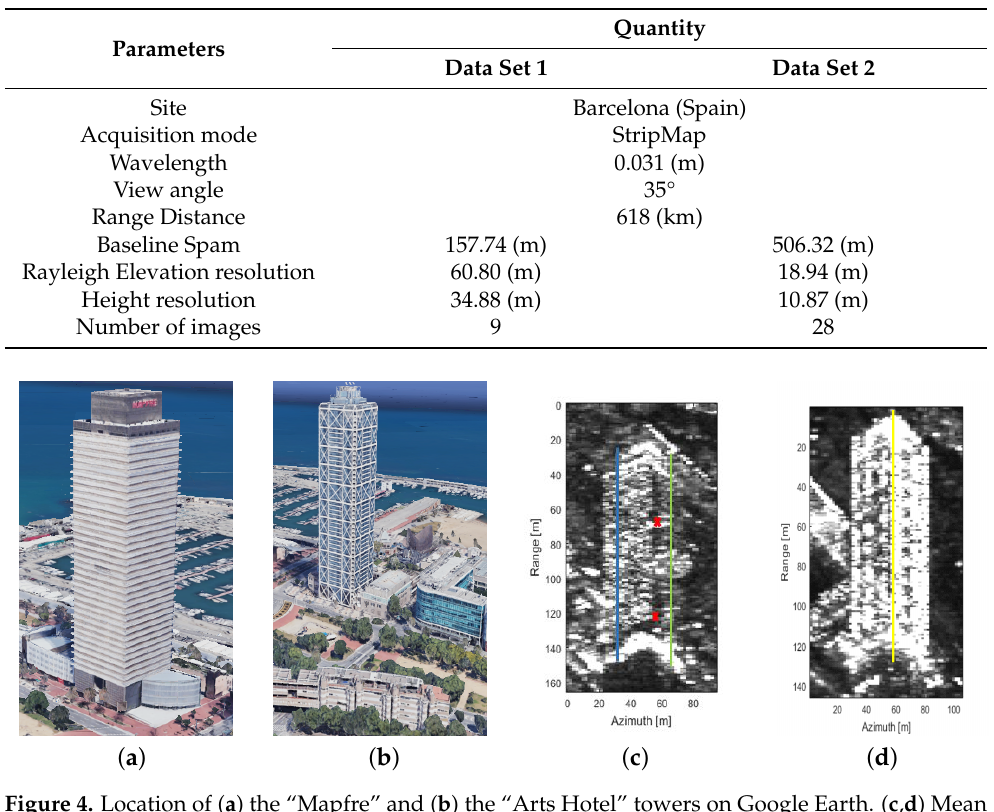
Figure 4. Location of ( a ) the “Mapfre” and ( b ) the “Arts Hotel” towers on Google Earth. ( c , d ) Mean amplitude maps with considered profiles and resolution